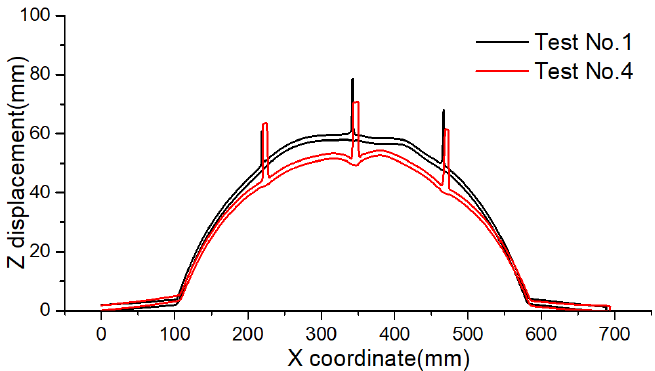
Figure 20. Central H-H section profile of Tests No. 1 and 4.